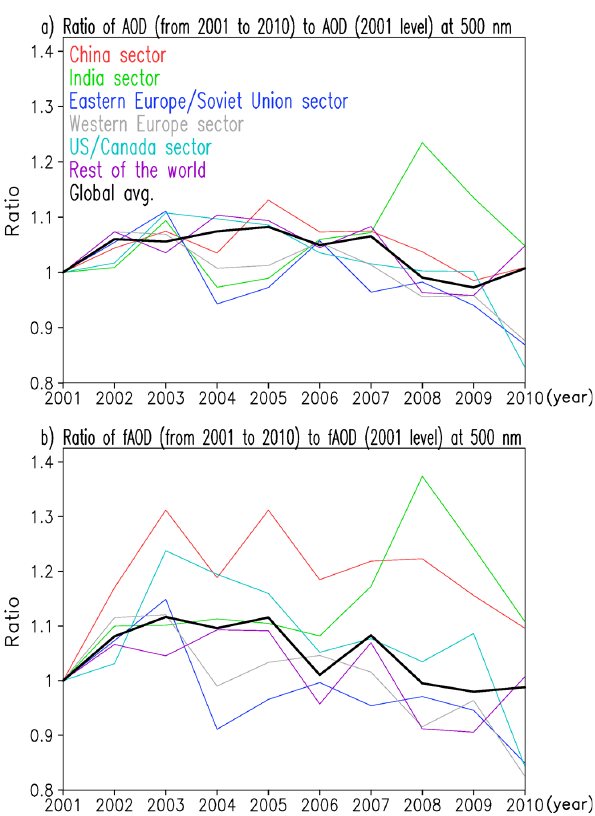
Fig. 9. Ratio of regionally averaged annual-mean AOD (or fAOD) to its 2001 level. Here, we use our best estimates of AOD (fAOD). See Fig. 8 for the division of the